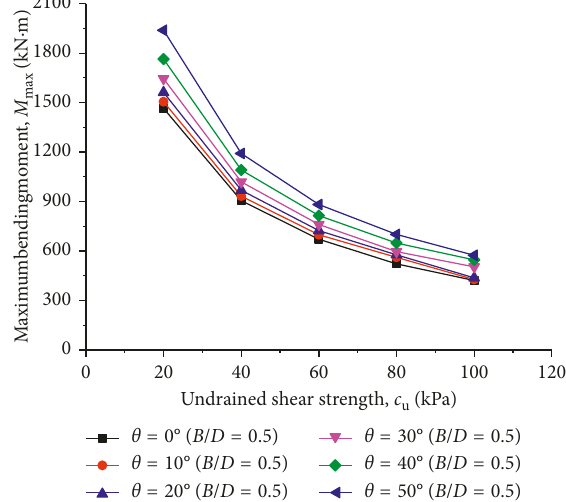
Figure 24: Maximum bending moment ( M undrained shear strength ( c u ) for different slope